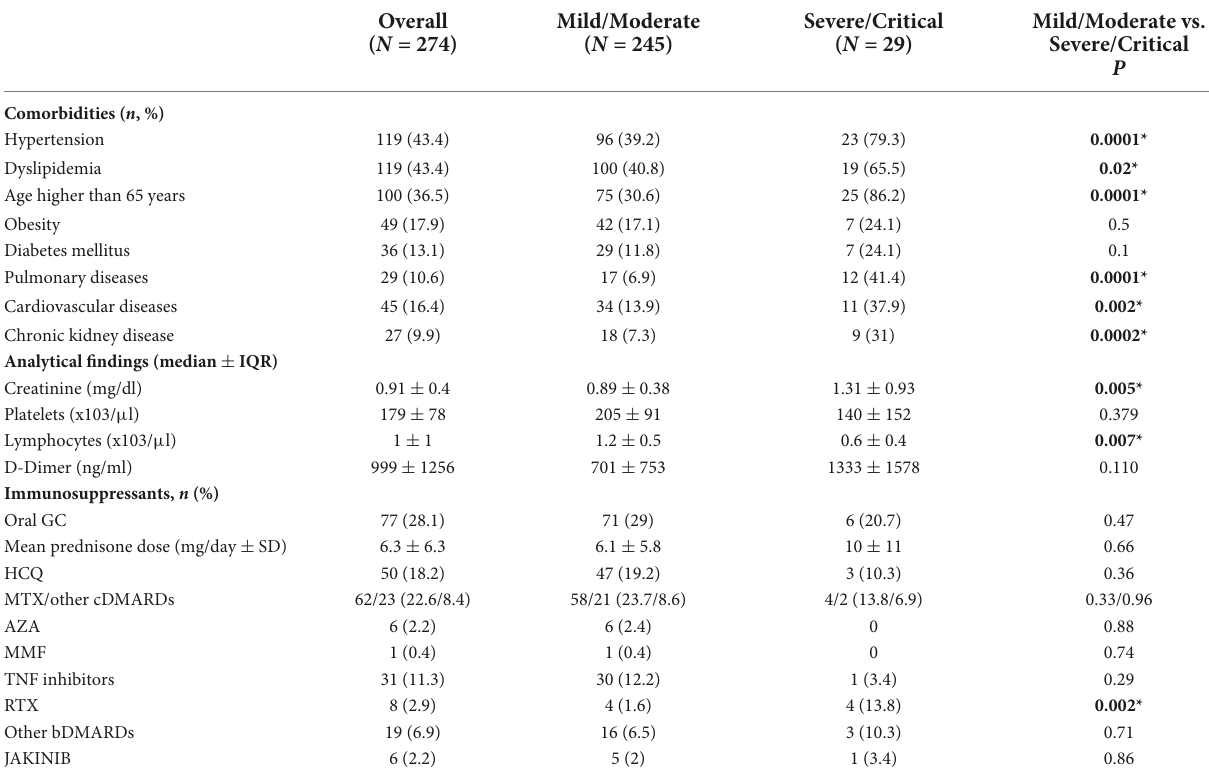
TABLE 5 Clinical severity of 274 with rheumatic immune-mediated diseases (R-IMID) diagnosed with coronavirus disease 2019 (COVID-19) [analytical findings and Immunosuppressants are at coronavirus (COVID) diagnosis].